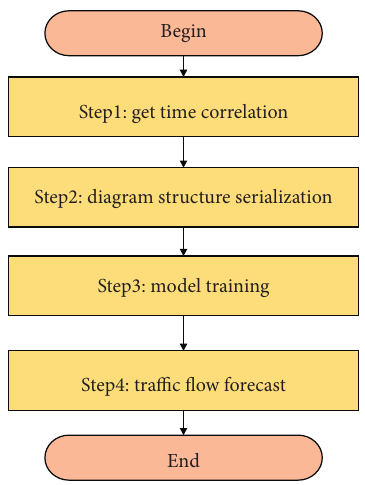
Figure 8: RNN-GCN model implementation